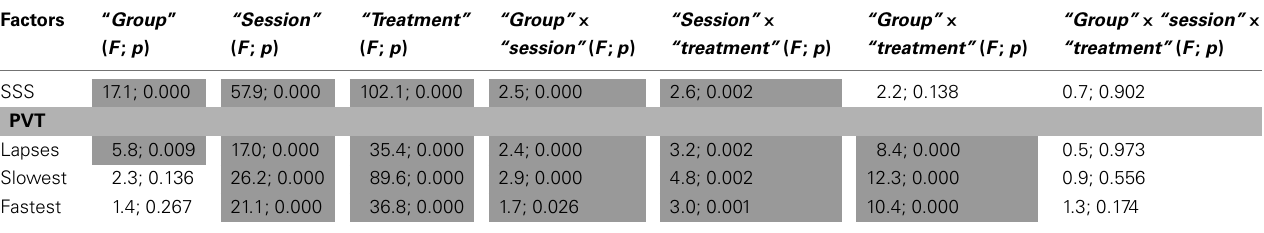
Table 1 | Statistical analyses of subjective sleepiness and sustained vigilant attention across 40h prolonged wakefulness. Factors